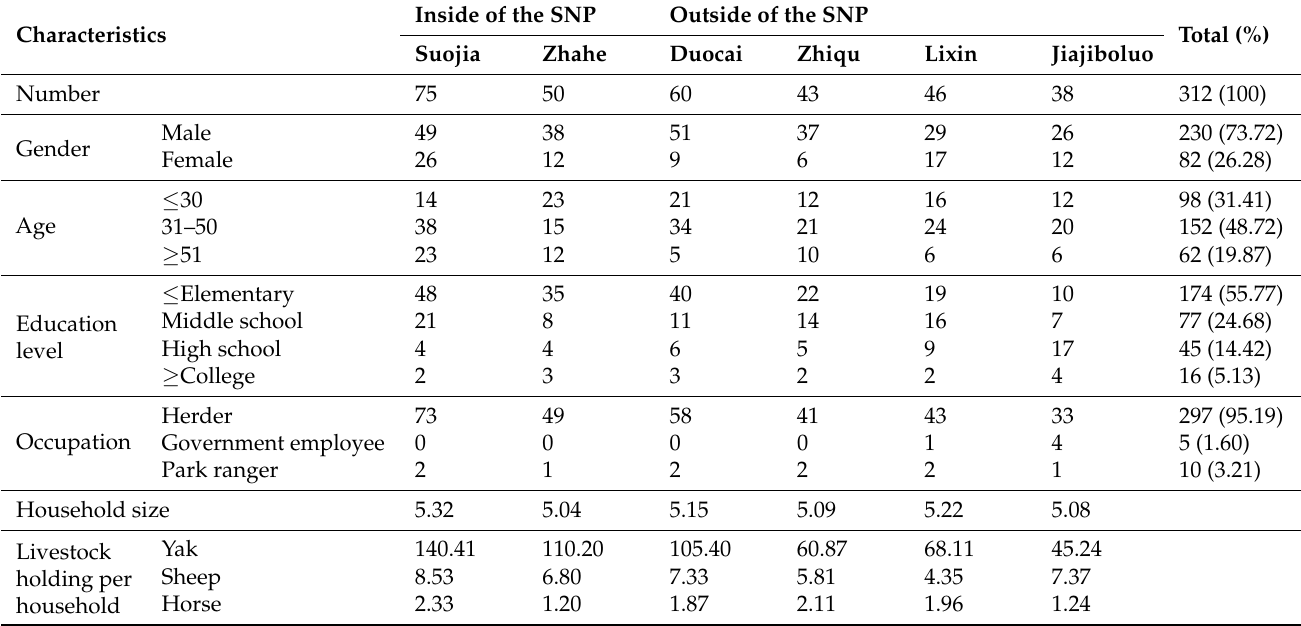
Table 2. Socio-demographic information of